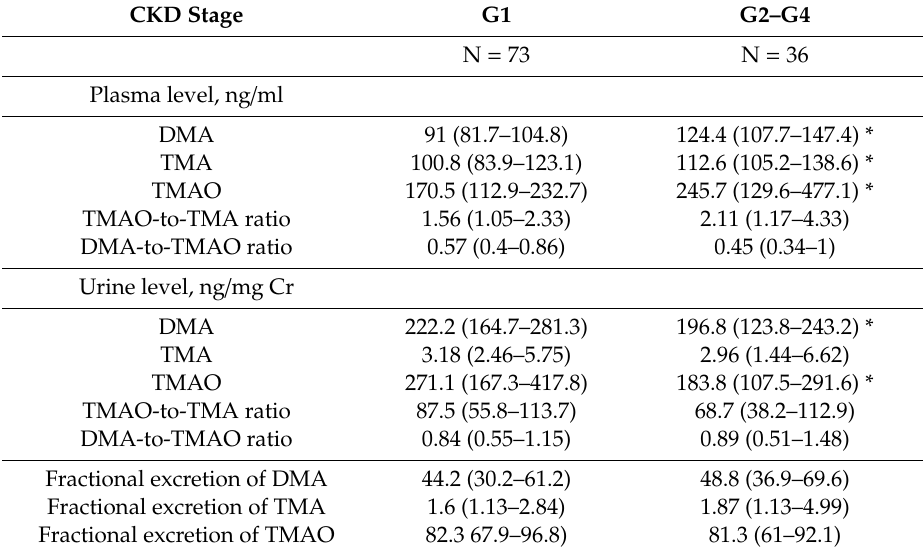
Table 3. Plasma and urinary levels of dimethylamine (DMA), trimethylamine (TMA), and trimethylamine N-oxide (TMAO) in children and adolescents with CKD stage G1–G4.